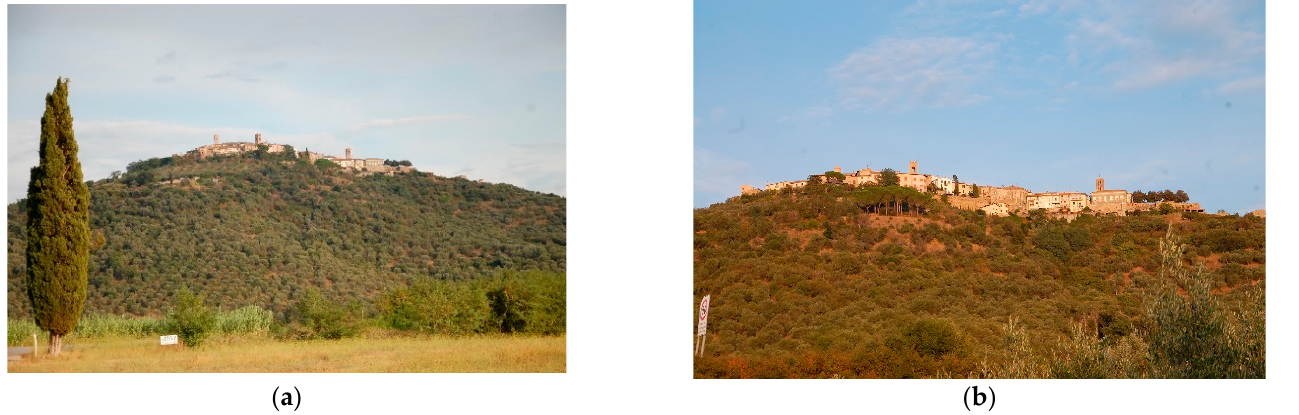
Figure 2. ( a ) View of Montepescali from the highway 1; ( b ) View of Montepescali from the Grosseto-Siena railway line. (Credits: Francesca Floris).